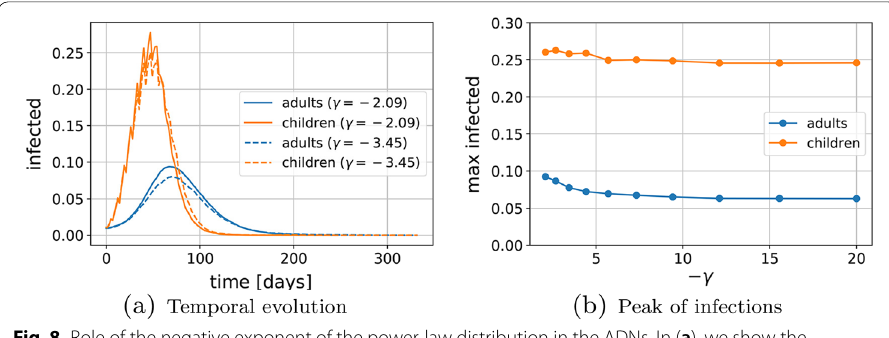
Fig. 8 Role of the negative exponent of the power-law distribution in the ADNs. In ( a ), we show the temporal evolution of the number of infected children and adults (averaged over 10 runs), for two different choices of the power-law exponent. In ( b ), we show the peak of the epidemic prevalence (estimated over 100 runs), for increasing values of the negative exponent of the power law. All simulations are performed in the absence of vaccination V = 0 for Scenario I (original strain). The parameters used in the simulations are listed in Table 2, q a = 0.25 , and q c =